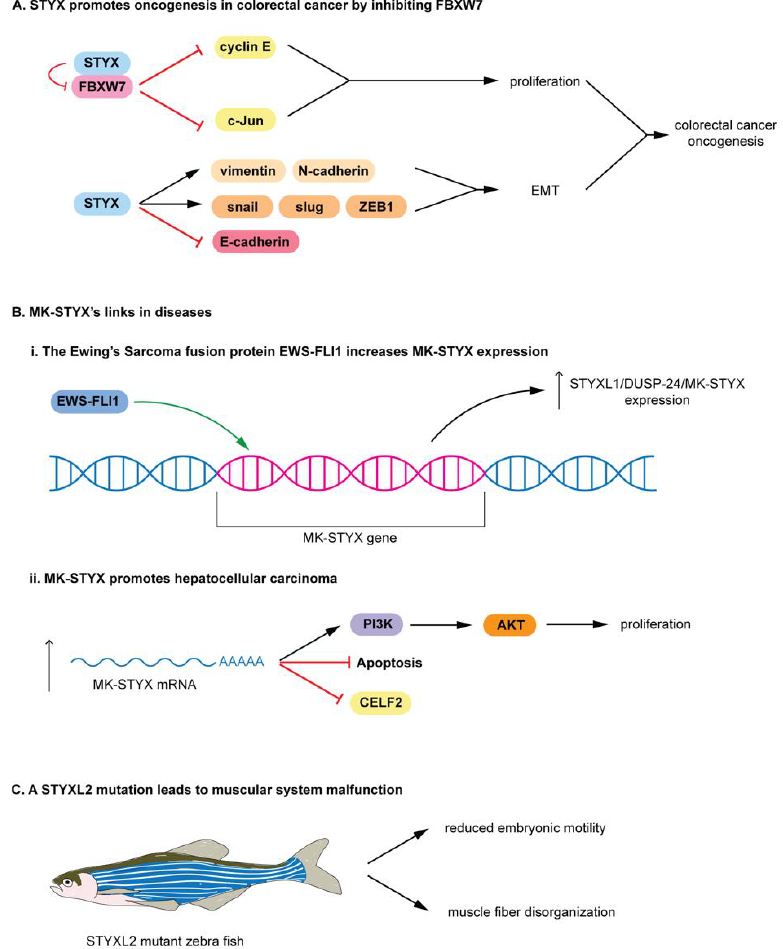
Figure 6. Roles of STYX domain pseudophosphatases in disease: ( A ) Prototypical STYX roles in colorectal cancer. STYX promotes oncogenesis in colorectal cancer by inhibiting FBXW7. STYX binds FBXW7, preventing other interactions of FBXW7, which is a substrate recruiter for a ubiquitin